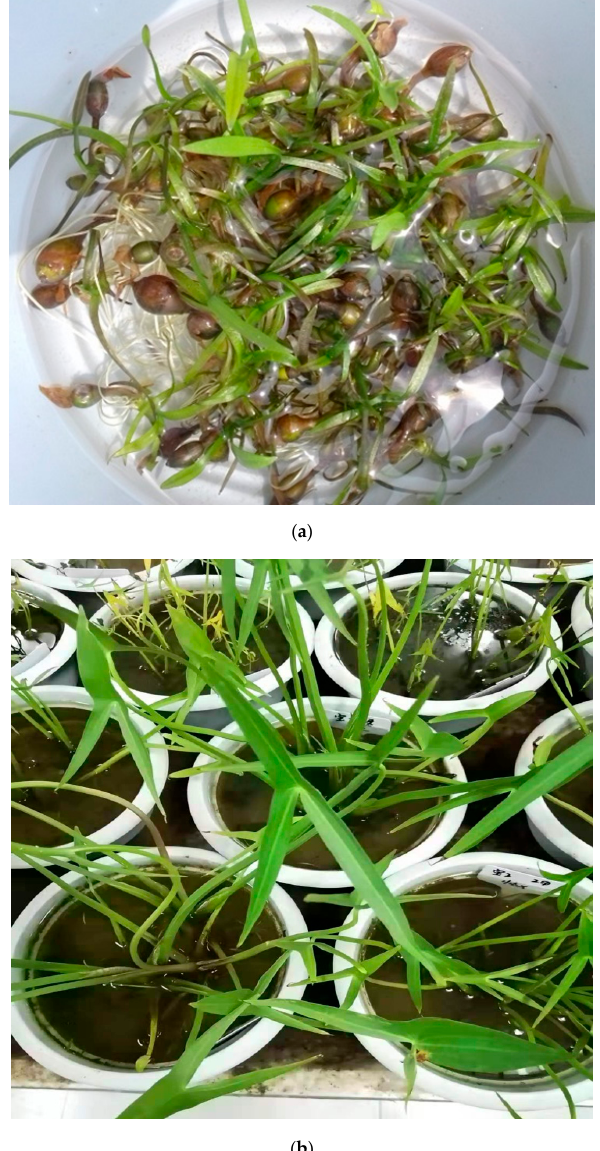
Figure 5. Sagittaria trifolia : ( a ) newly sprouted corms; ( b ) plants at 6–7 leaves stage.